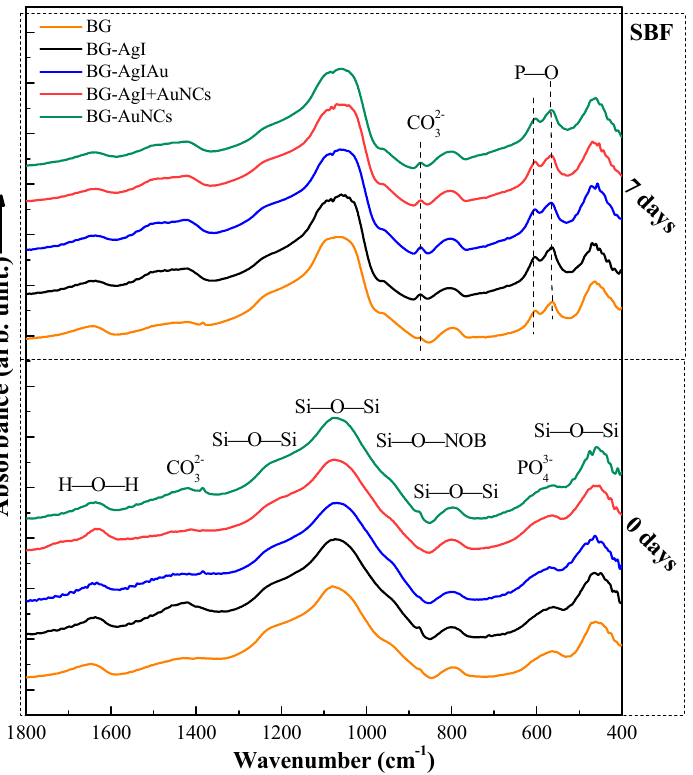
Figure 5. FT-IR spectra of the BG, BG-AgI, BG-AgIAu, BG-AgI+AuNCs, and BG-AuNCs samples before (0 days) and after (7 days) immersion in SBF.